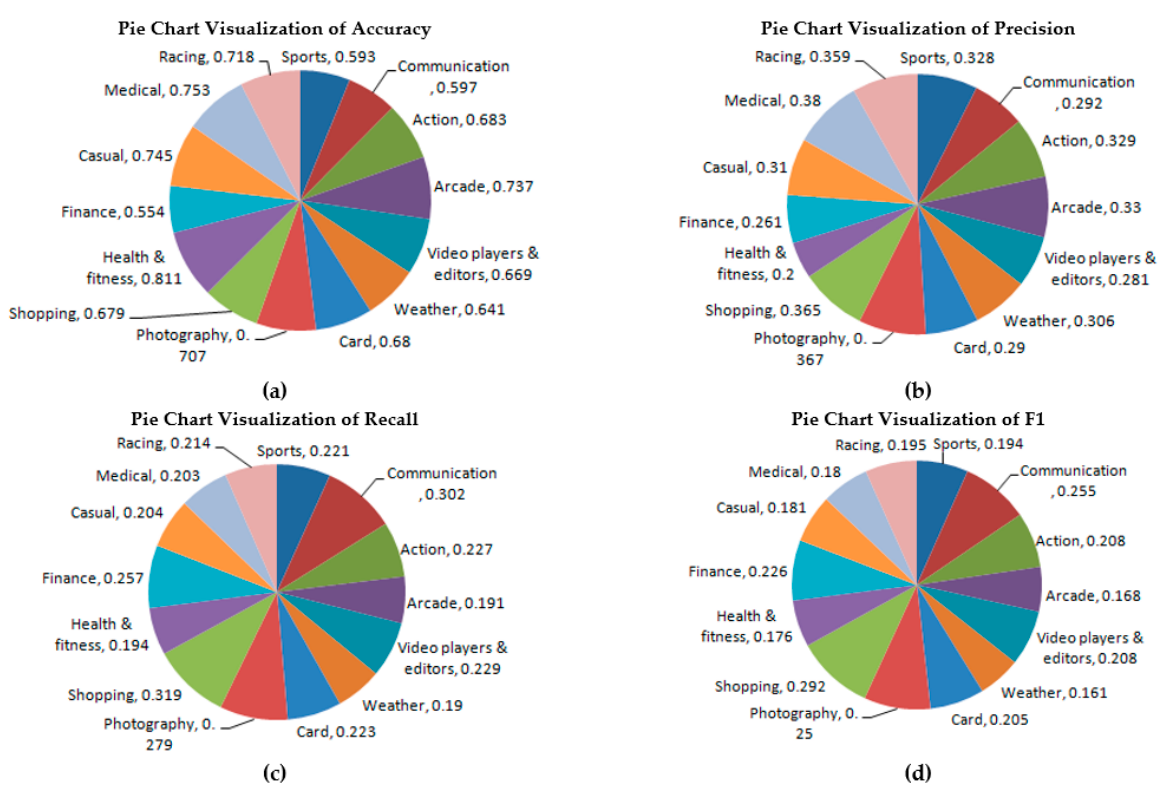
Figure 12. Pie chart visualization of different machine-learning algorithm comparison on TF/IDF based without preprocessing of data.